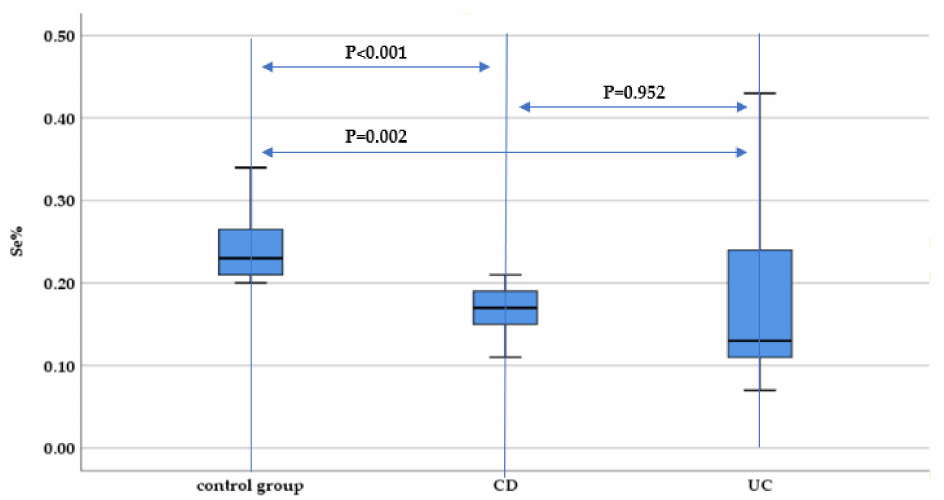
Figure 8. Evaluation of hair selenium concentration (Se%) between IBD subtypes (UC and CD) and the control